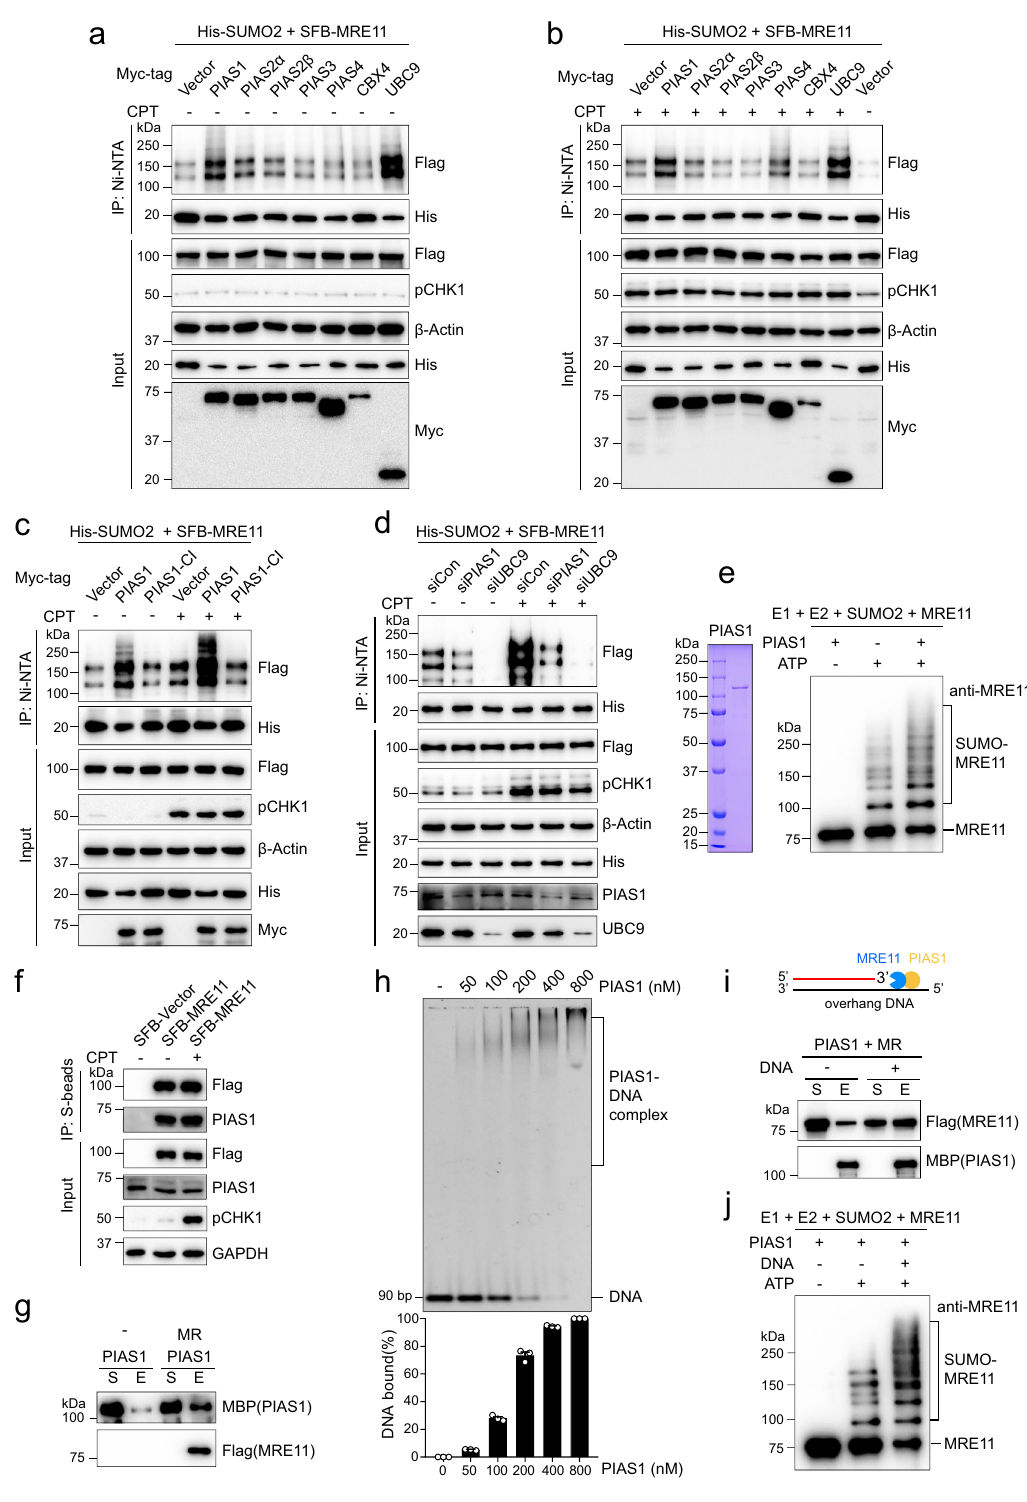
recombinant 4KR fused with a C-terminal 2× or 3× poly-SUMO2 chain (Fig. 6a). We found that the ubiquitylation of 4KR was signi fi cantly reduced by the addition of the poly-SUMO2 chain (Fig. 6b). Fur- thermore, DNA end resection and cell viability following DNA damage were assayed by immunoblotting and cell counting kit-8 (CCK-8) assays. As shown in Fig. 6c, d, the poly-SUMO2 chain fused to 4KR successfully relieved the DNA end resection defect and